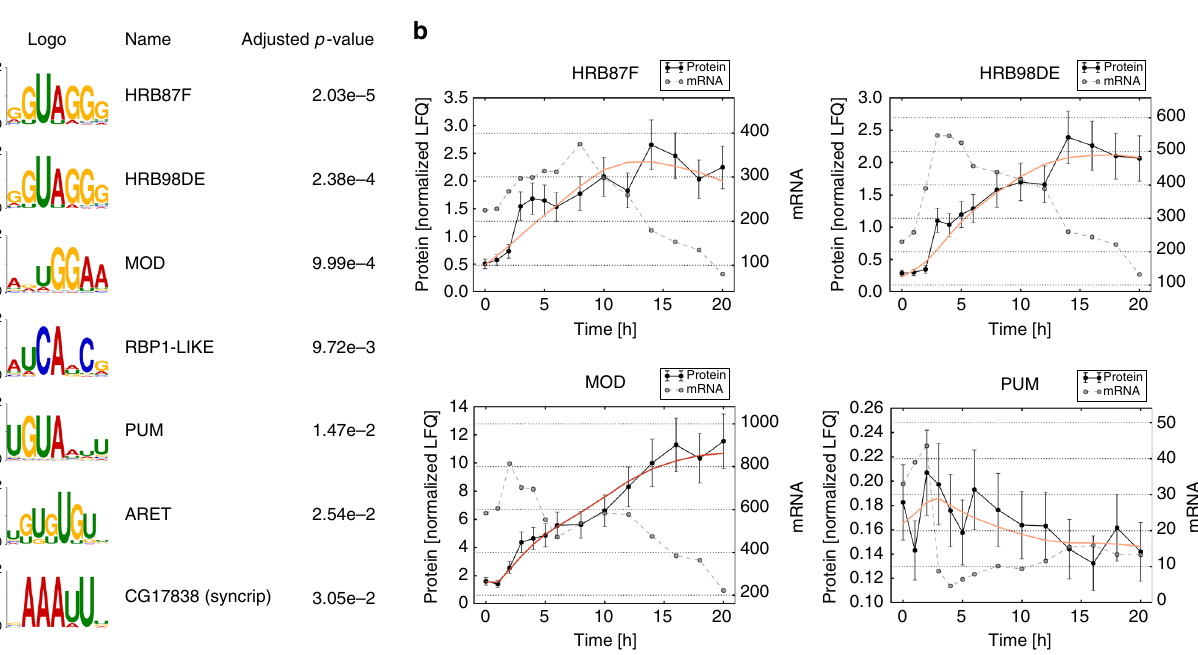
Fig. 6 Post-transcriptionally regulated proteins are enriched for RBP binding motifs. a Seven RBP sequence motifs are enriched in the group of potentially post-transcriptionally regulated proteins (adjusted enrichment p value < 0.05). In total we scanned for enrichment of 67 Drosophila- speci fi c motifs corresponding to 51 distinct RBPs. For each RBP, only the sequence logo with highest enrichment is shown. b Putative post-transcriptional regulators are regulated at the protein expression level during Drosophila development. Measured protein pro fi les (black solid line — normalized LFQ) of four RBPs, alongside their corresponding mRNA expression (dashed gray line) and the best model fi t (colored line) are presented. Error bars represent standard deviation of protein according to a linear error model. The expression level of the three remaining RBPs (RBP1-LIKE, ARET, and CG17838) were below the